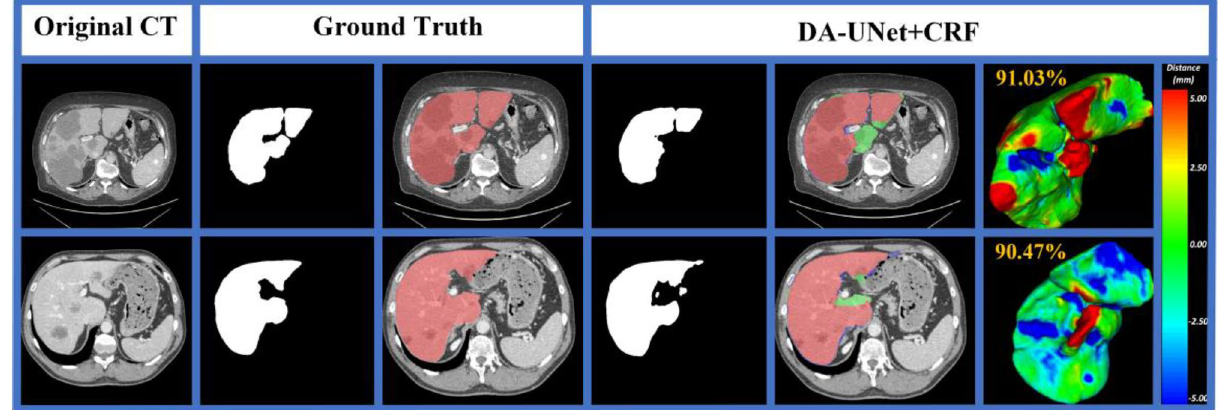
Figure 8. Illustrations of limitations of the proposed model with liver boundaries containing tumors. In the 2D error visualization, the red region denotes the ground truth, blue/green region represents the under-/ over-segmentation. In the 3D error visualizations, the blue/red indicates under-/over-segmentation, and green indicates consistent results with the ground